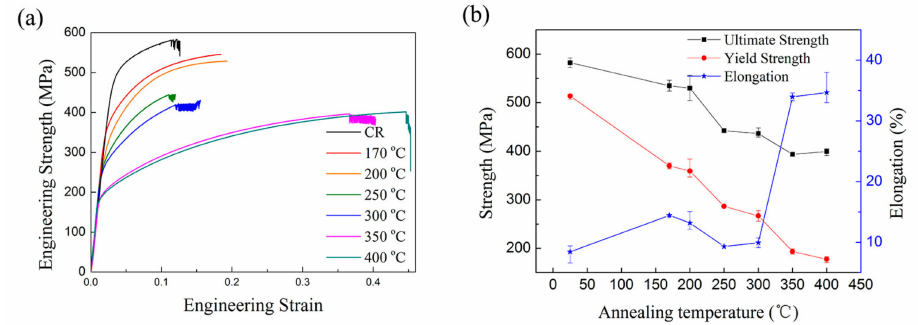
Figure 6. Typical ( a ) engineering stress–strain curves and evolution ( b ) of mechanical properties of Al–10Mg alloy sheet annealed at di ff erent